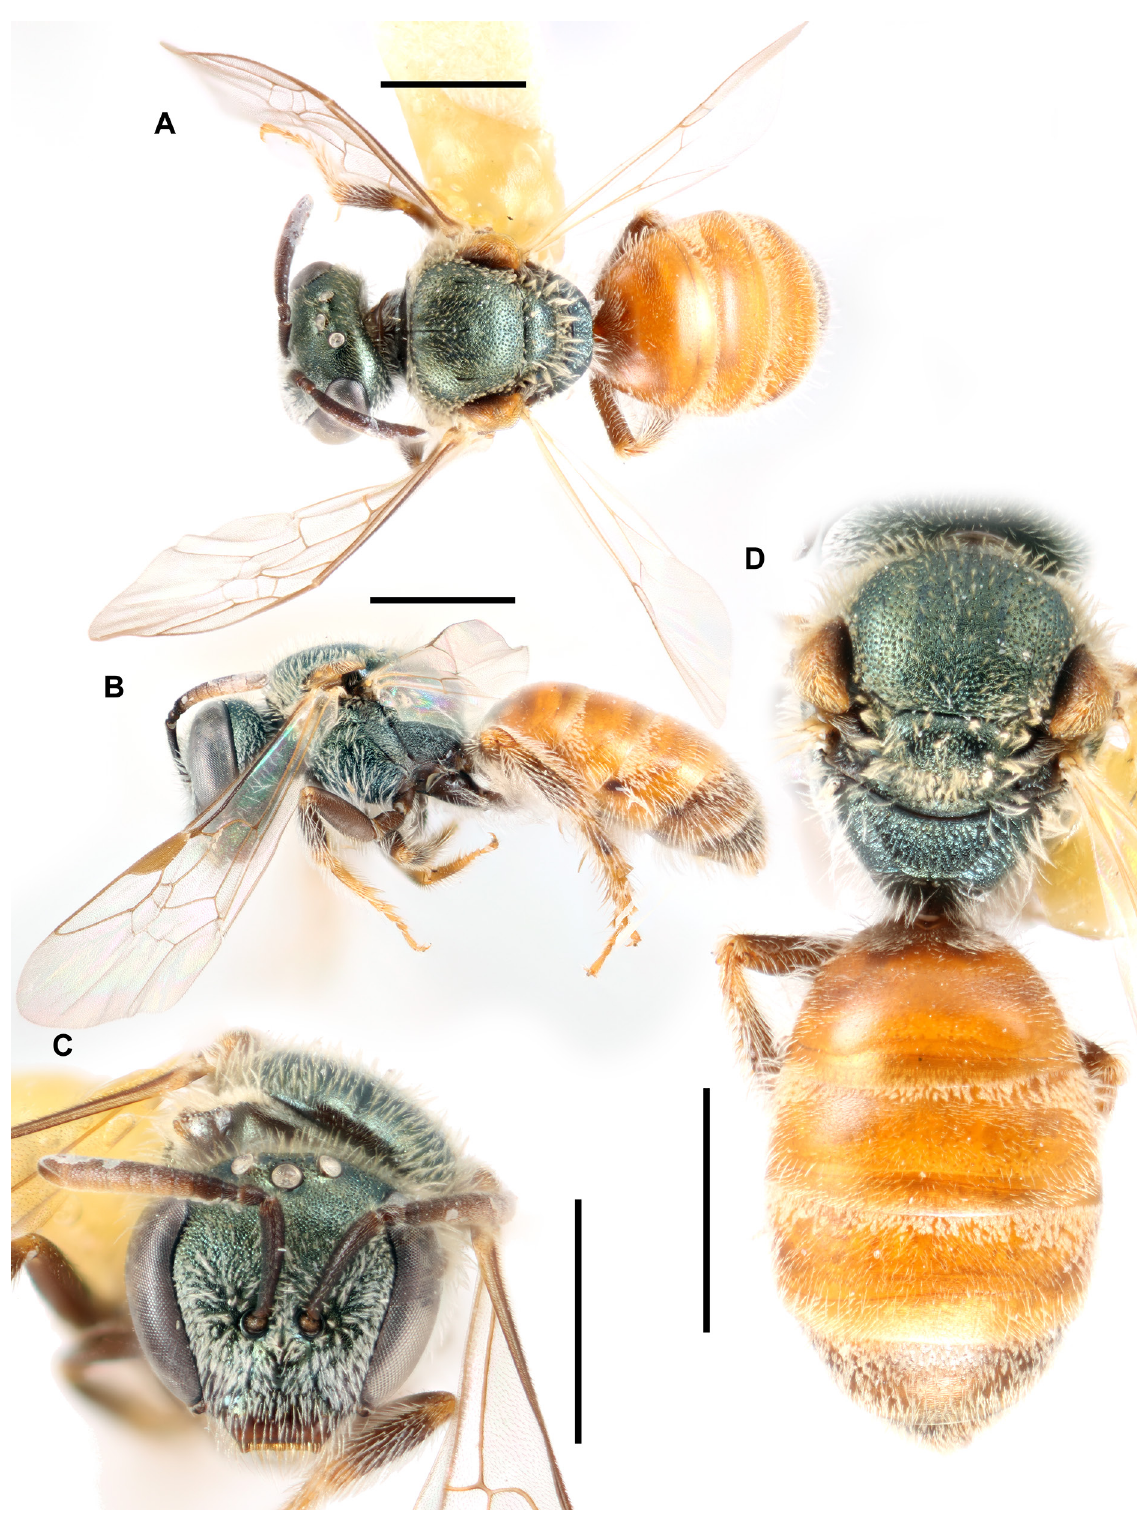
Fig. 62. Lasioglossum ( D .) stictaspis (Sandhouse, 1923), ♀, red-tailed morph. A . Dorsal habitus. B . Lateral habitus. C . Face. D . Metasoma and propodeum. Scale bars = 1